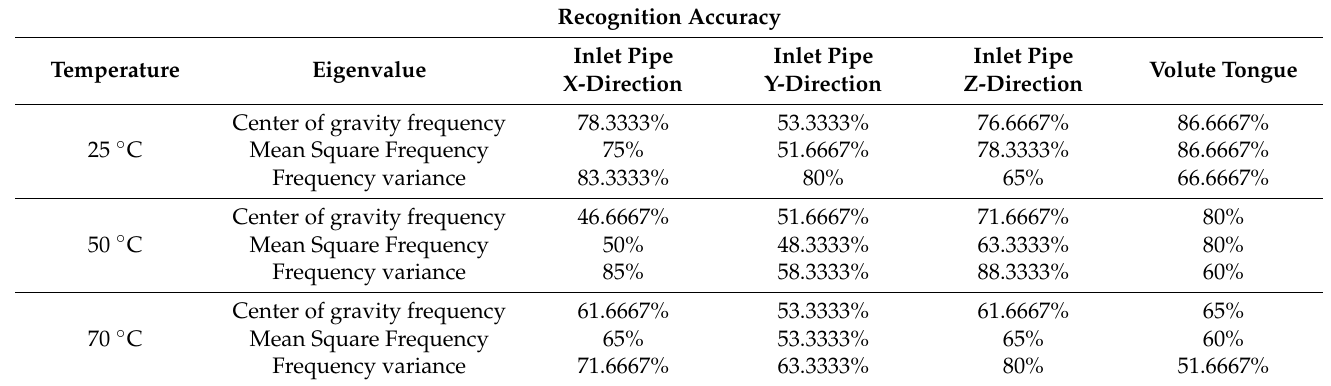
Table 2. Accuracy of frequency-domain eigenvalue classification.